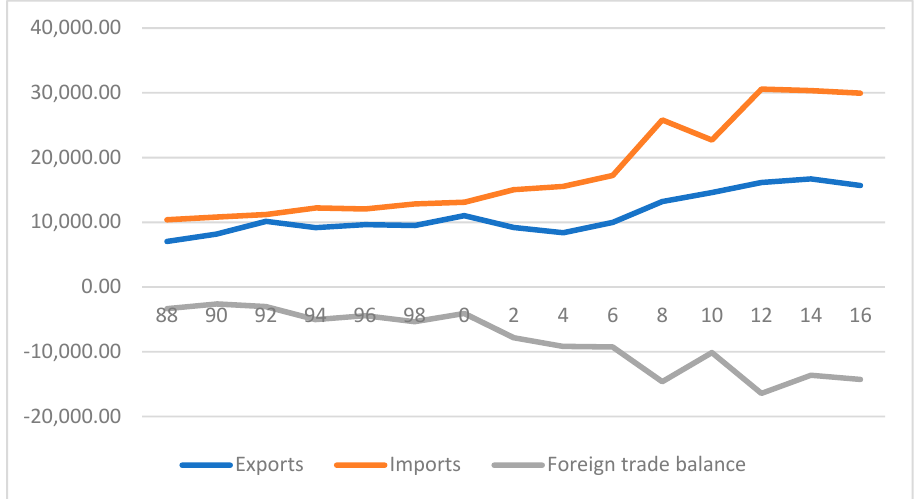
Figure 6. Evolution of foreign trade in continental products (millions of euros, current prices). Source: own elaboration based on data obtained from EUROSTAT.